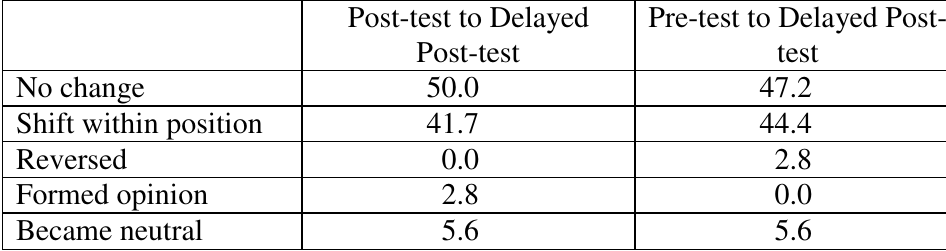
Table 5. Percentage of Participants Exhibiting Changes in Ratings of Energy Conservation and Efficiency